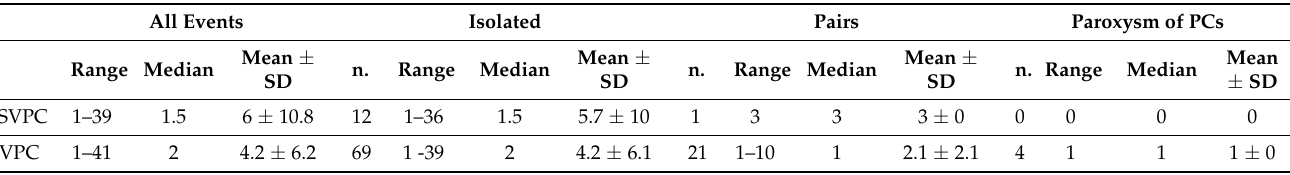
Table 2. Distribution of rhythm disturbances, recorded in 158 Standardbred trotter racehorses, expressed as the number of complexes per horse. All Events Isolated Pairs Paroxysm of PCs Mean ± Range Median